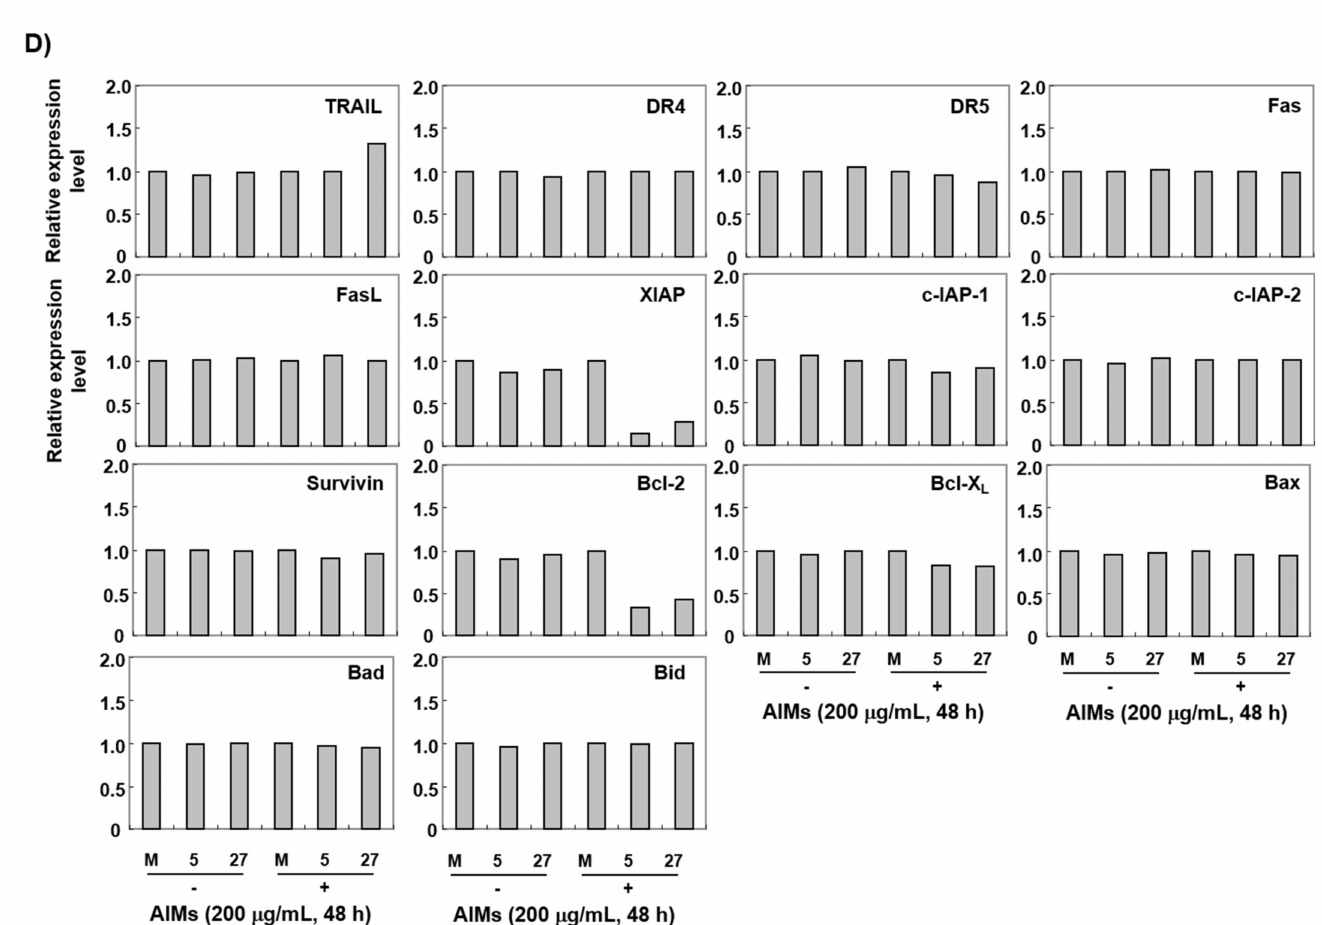
Figure 5. The mechanisms for ERH-augmented apoptotic effect on AIM-treated cells: mitochondrial depolarization and inhibition of Bcl-2 and XIAP expression. The cells were seeded at the density of 5 × 10 4 cells per mL. The two kinds of E-MKN28 cells (eoERH#5 and eoERH#27) and M-MKN28 cells were treated with AIMs at the concentrations of 200 µ g/mL for 48 h. ( A ) AIMs induced more loss of MMP ( ∆Ψ m ) (mitochondrial depolarization) in E-MKN28 cells than M-MKN28 cells. ( B ) The data are shown as means ± SD of three independent experiments. ‘*’ represents significance (* p < 0.05 between AIM-treated E-MKN28 cells and AIM-treated M-MKN28 cells). ( C ) Western blot analysis, which revealed that ERH decreased the expression of antiapoptotic protein XIAP and Bcl-2 in both AIM-untreated and AIM-treated cells. The Western blot analysis data are representative of three independent experiments. ( D ) Densitometry analysis of the data in Western blot analysis by ImageJ software. The values were normalized against β -actin. (* p < 0.05 between AIM-treated E-MKN28 cells and AIM-treated M-MKN28 cells). M, M-MKN28 cells; 5, eoERH#5 E-MKN28 cells; 27, eoERH#27 E-MKN28